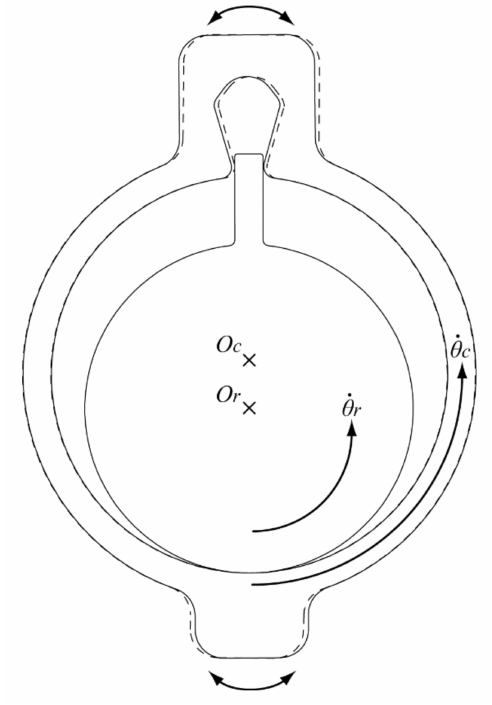
Figure 9. Secondary vibration